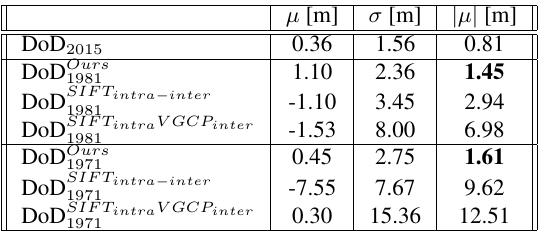
Table 3. Average µ , standard deviation σ , and absolute average | µ | of the Z-coordinate in the 7 DoDs in Figure